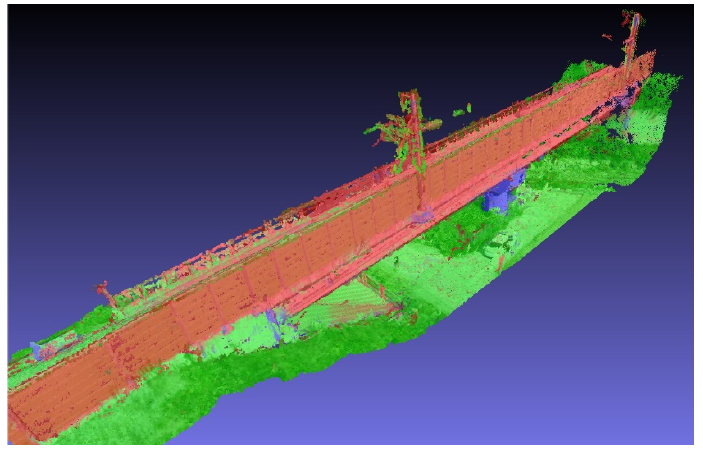
Figure 13. Semantic PCD of the Osong 3rd test track bridge. Table 6. SSfM results.